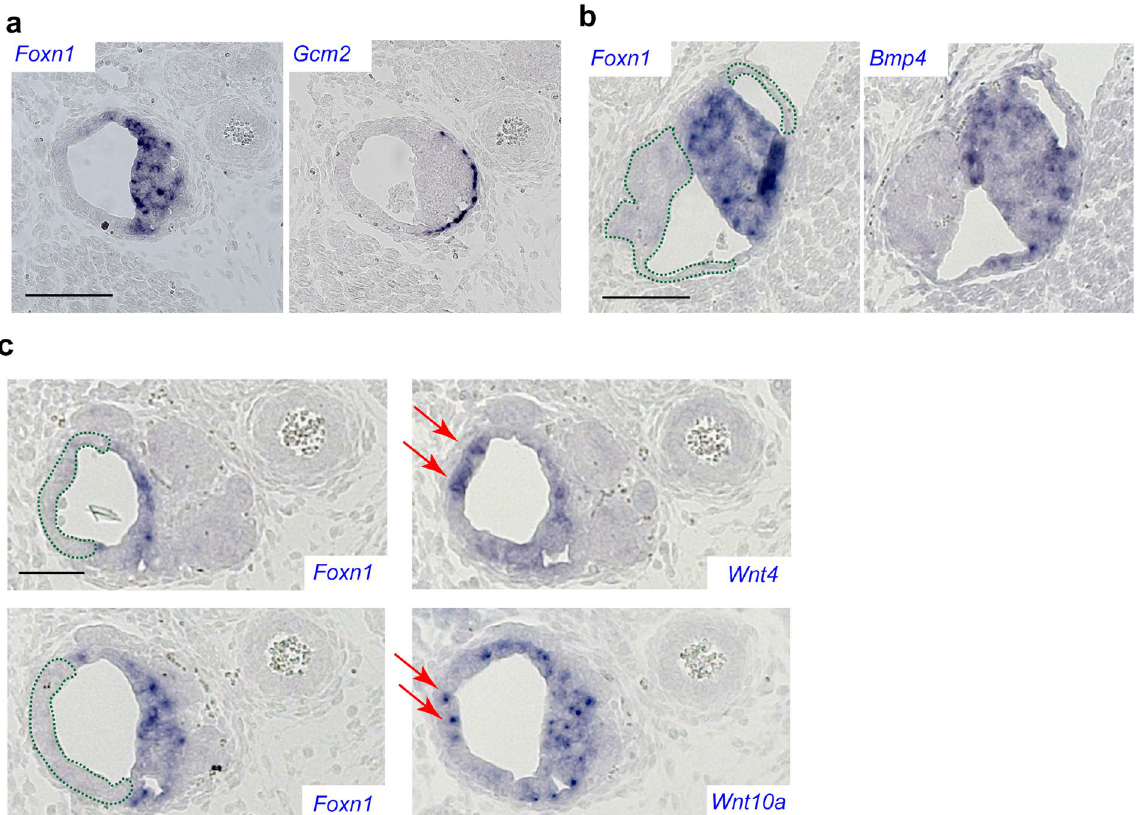
Figure 4. Unusual phenotype of thymic epithelia as revealed by RNA in situ hybridization. ( a ) Apposition of thymic ( Foxn1 -positive) and parathyroid ( Gcm2 -positive cells) in Foxn1 + / + ; Foxn1:Noggin mice. ( b ) Lack of Bmp4 expression in Foxn1 -negative epithelia in Foxn1 + / + ; Foxn1:Noggin mice; the results for two consecutive sections are shown. ( c ) Expression of Wnt4 , and Wnt10a genes in the Foxn1 -negative compartment of the thymic rudiment of Foxn1 + / + ; Foxn1:Noggin mice. Regions of Foxn1 -negative TECs are marked with green dotted lines in ( b ) and ( c ). Red arrows point to Foxn1 -negative cells expressing ectopic genes in panel ( c ). Mice were analysed at day 15.5 of embryonic development. The probes used are indicated in the top left corner in panels (a) and (b), and in the bottom right corner in panel (c); positive cells are stained blue. Scale bars, 100 μ